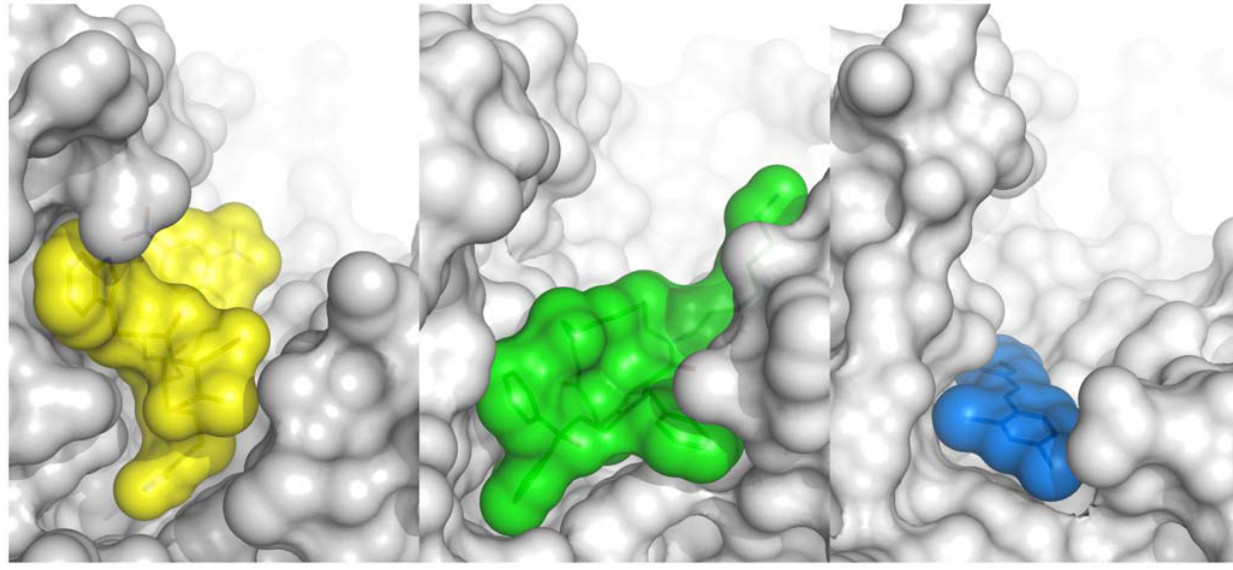
Figure 8. Cross-Section Views of HPM, AHP, and DCCH bound in the BoNTAe active site. Left: HPM with carbon in yellow obtained from the crystal structure of 3DS9 [18]; middle: AHP with carbon in green obtained from the MMDS-generated model; right: DCCH with carbon in blue obtained from the crystal structure of 2IMA [41]. Oxygen, nitrogen, and zinc are shown in red, blue, and light blue, respectively. BoNTAe is shown in white surface model with 15%